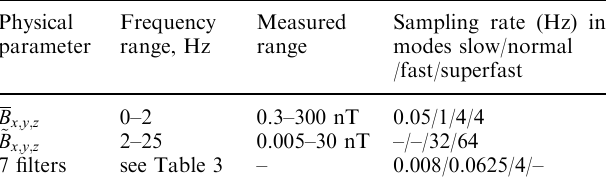
Table 2. ASPI parameters transmitted via PRAM in the digital form Physical Frequency Measured Sampling rate (Hz) in parameter range, Hz range modes